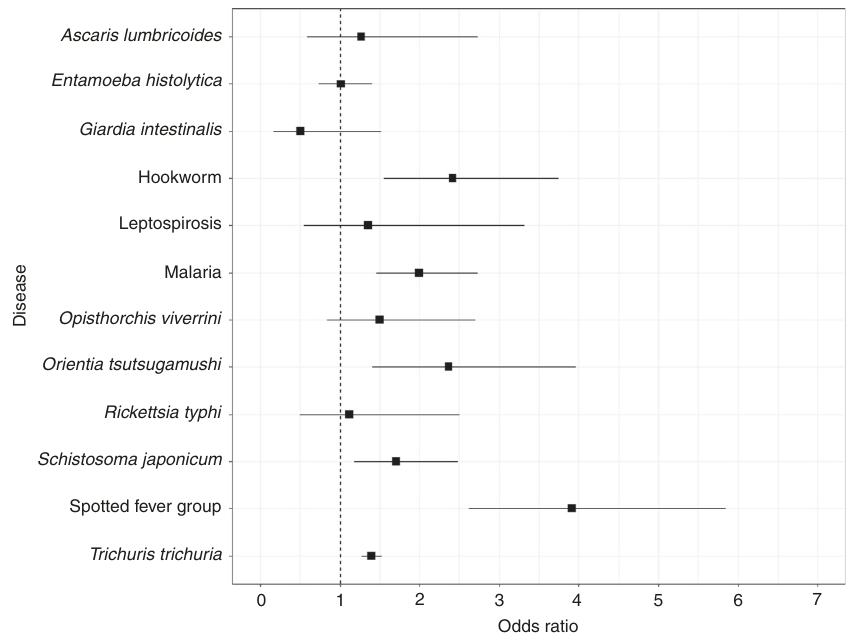
Fig. 7 Disease-based subgroup analysis. Subgroups were created a priori based on diseases that had two or more mutually exclusive estimates. Orientia tsutsugamushi is also known as Scrub typhus. Rickettsia typhi is otherwise known as murine typhus. Opisthorchis viverrini is also known as Opisthorchiasis. Square points show the pooled subgroup estimates and error bars are de fi ned as the 95% con fi dence interval